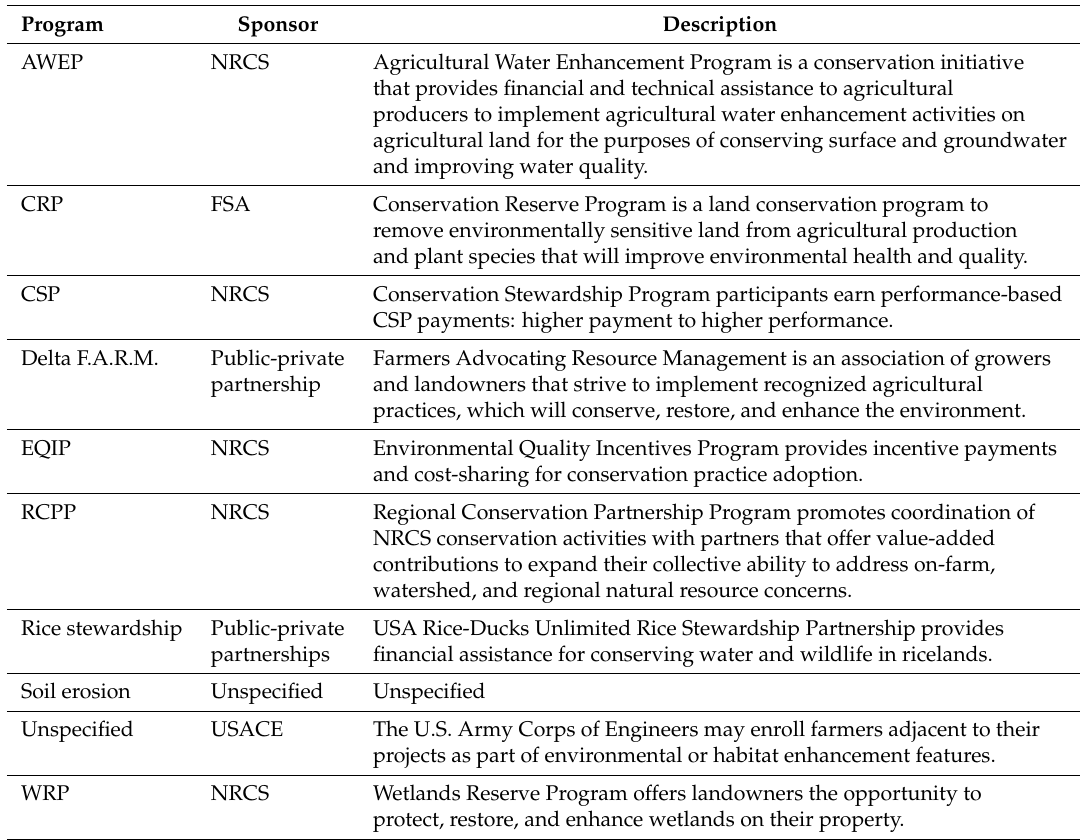
Table A1. List and brief description of the conservation programs in which survey respondents claimed to